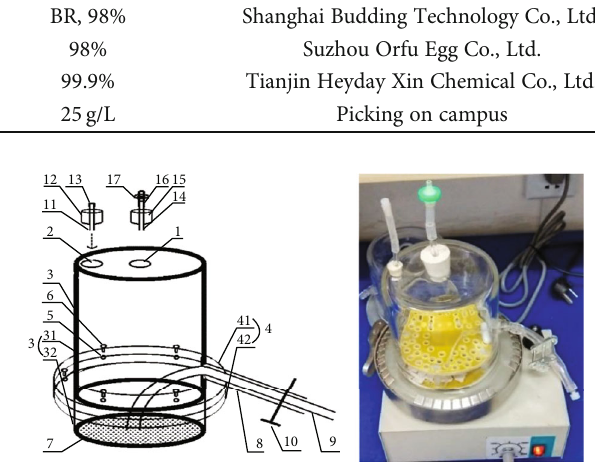
Figure 1: Structure of the reaction device in the solution test.